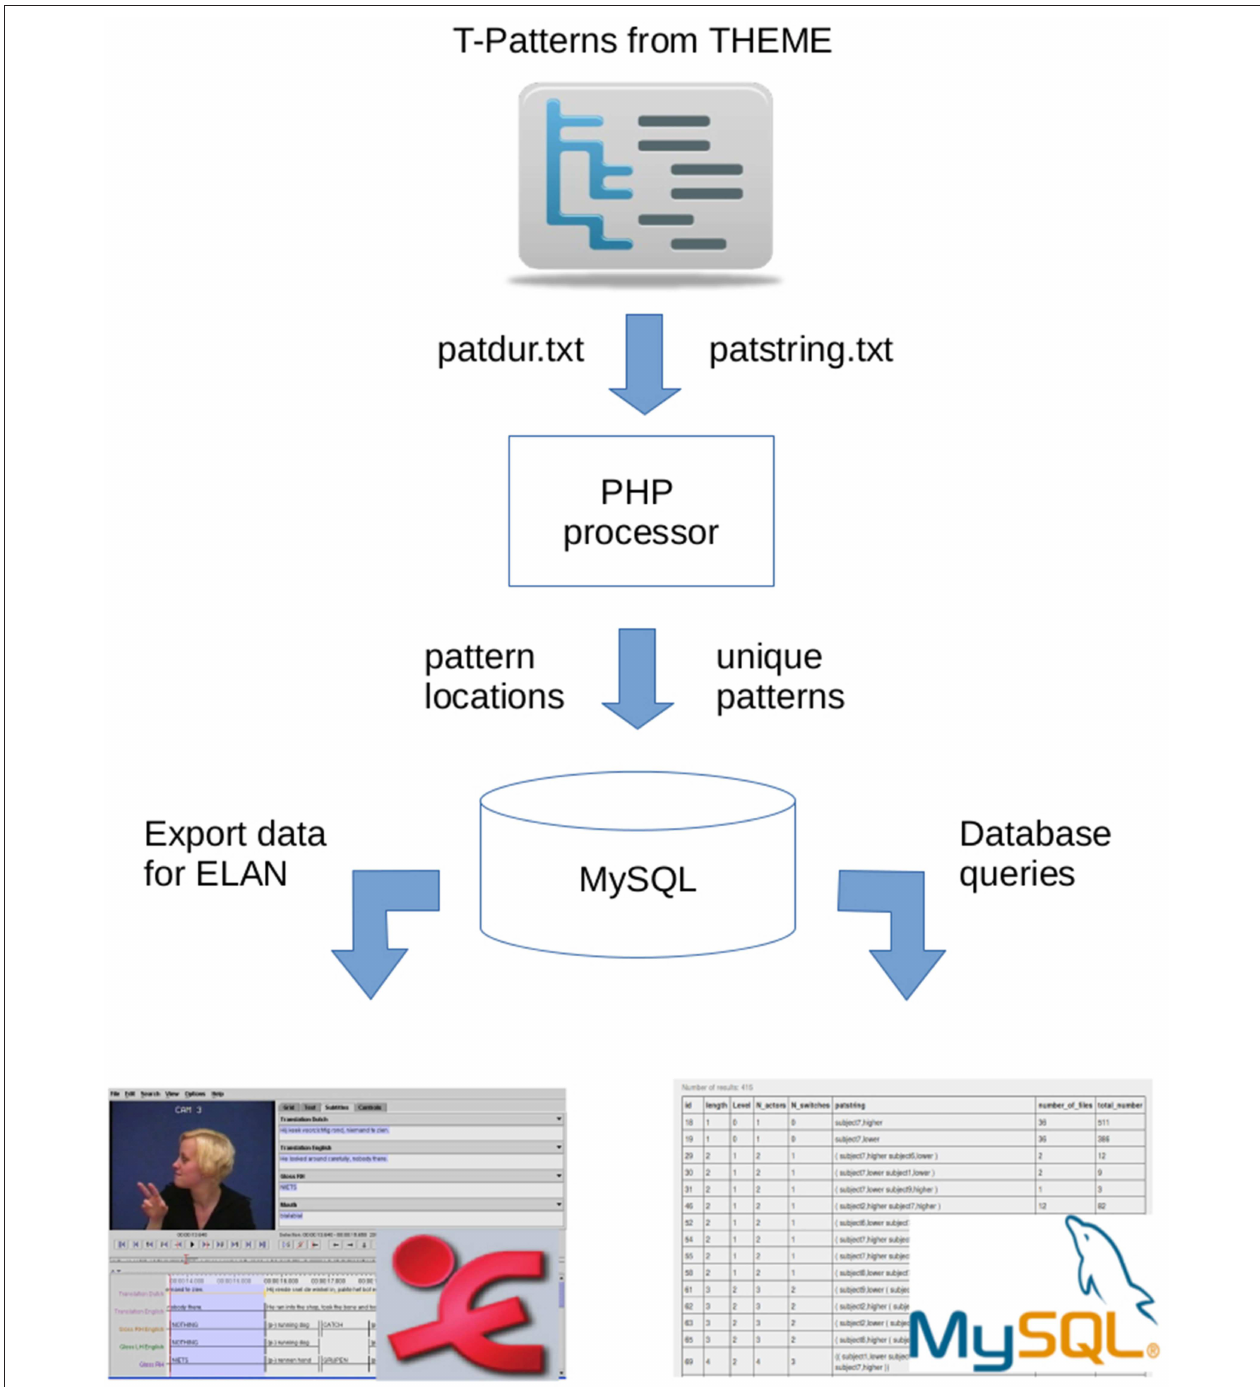
FIGURE 2 | The overview of data flow and the main components of the interface.